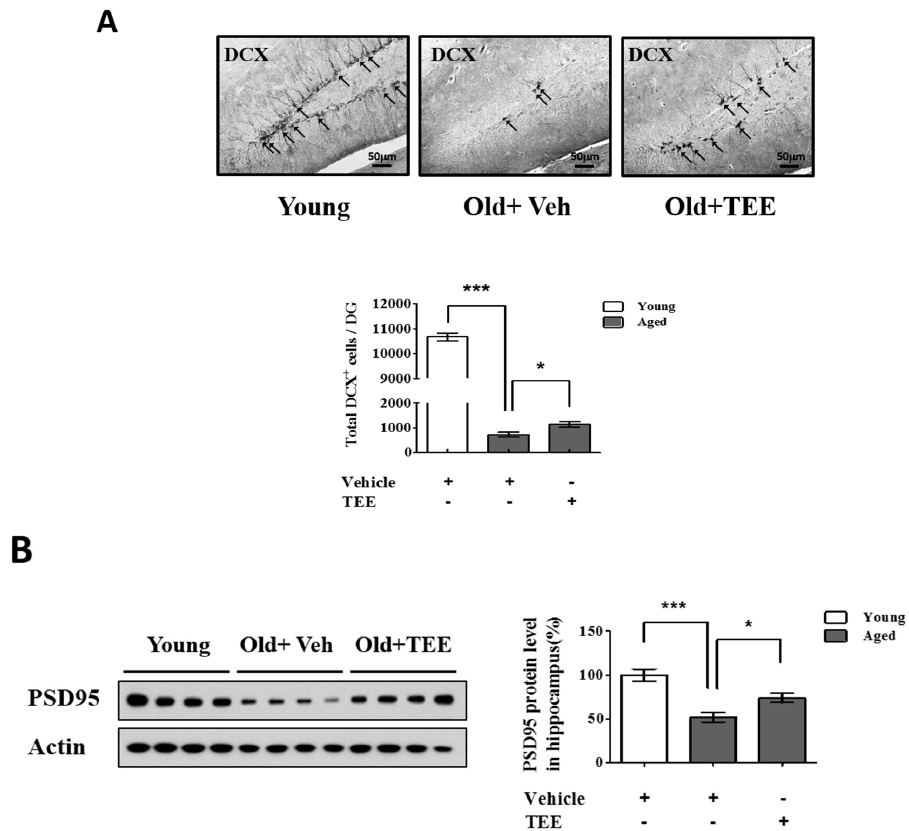
Figure 3. Oral administration of TEE improved hippocampal neurogenesis and synaptic density in aged mice. ( A ) To quantify the neurogenesis in dentate gyrus (DG), doublecortin (DCX) immunostaining was performed. Representative photographs of DCX + cells in the hippocampal region are shown. The arrows indicate DCX + cells, and the total number of DCX + cells in the DG were quantified in the graph